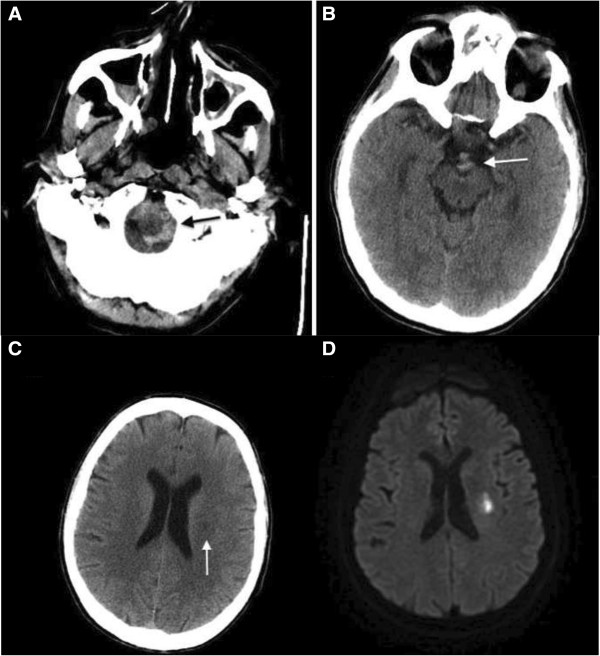
Initial non-contrast head computed tomography scan shows subarachnoid hemorrhage (arrows) (A, B); subsequent scan (C) shows ischemic lesion (arrow) that diffusion-weighted magnetic resonance imaging (D) confirms to be consistent with acute infarct.